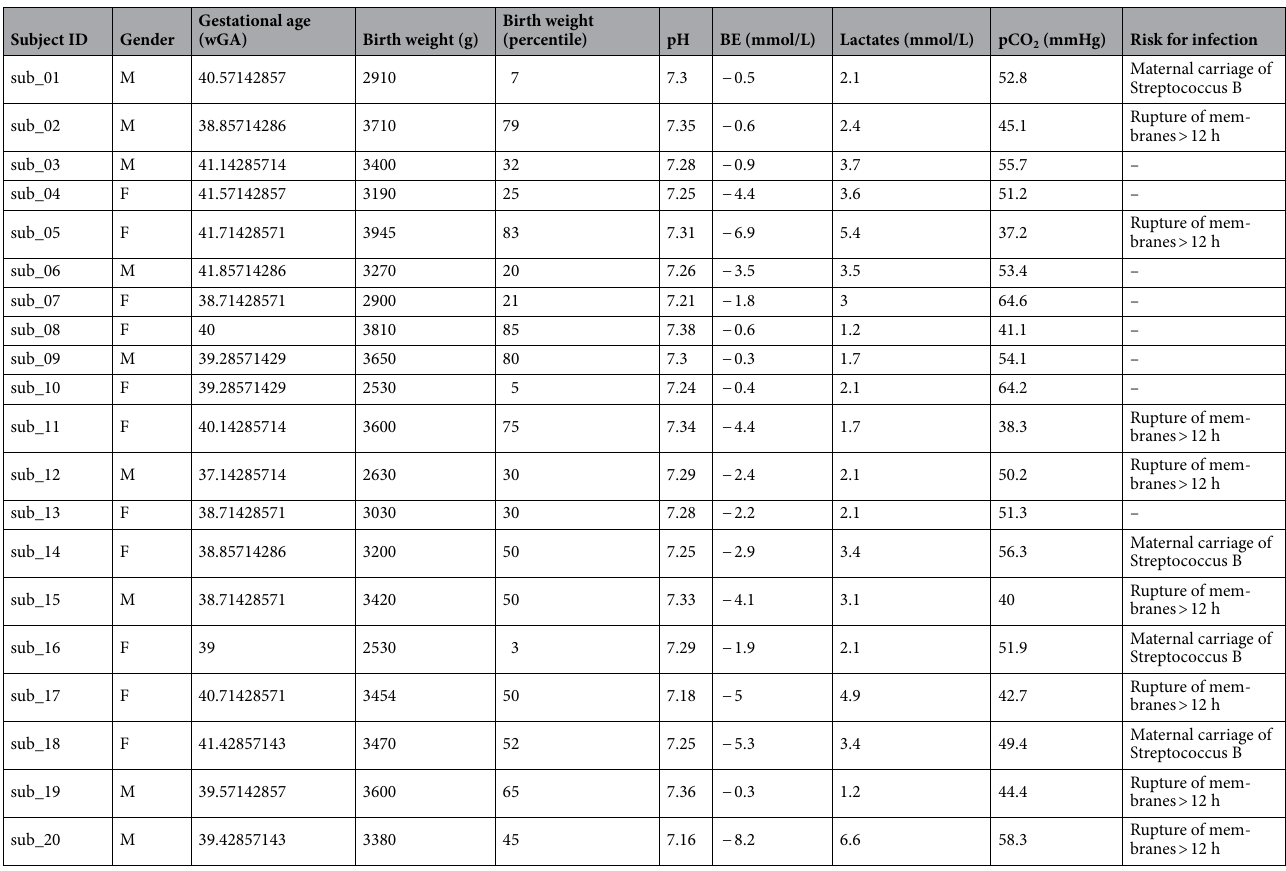
Table 1. Clinical features of the tested infants. M male, F